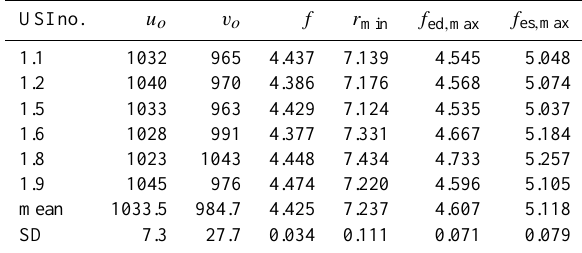
Table 2. Intrinsic parameters and lens focal length selection param- eters measured for 7 USI units. The principal point (u o ,v o ) and focal length f are measured for each USI. The minimum distance to the sensor edge r min from (u o ,v o ) yields the maximum allowable focal lengths f ed , max and f es , max for the equidistant and equisolid angle projections, respectively. Units are in mm, except for u o and v o which are given in pixels. USI